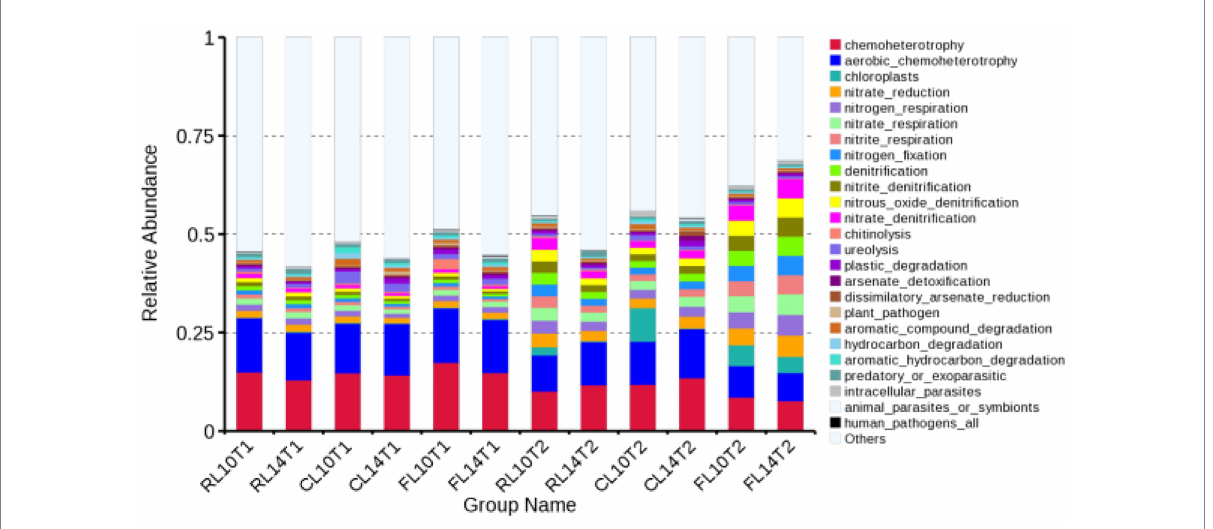
FIGURE 3 Relative abundance of functional bacteria in soil of soybean cultivars under crop rotation and continuous cropping. RL10T1, at the R1 growth stage, L10 under CR treatment; RL14T1, at the R1 growth stage, L14 under CR treatment; CL14T1, at the R1 growth stage, L14 under CC treatment; FL10T1, at the R1 growth stage, L10 under CF treatment; FL14T1, at the R1 growth stage, L14 under CF treatment; RL10T2, at the R6 growth stage, L10 under CR treatment; RL14T2, at the R6 growth stage, L14 under CR treatment; FL10T2, at the R6 growth stage, L10 under CF treatment; FL14T2, at the R6 growth stage, L14 under CF treatment.